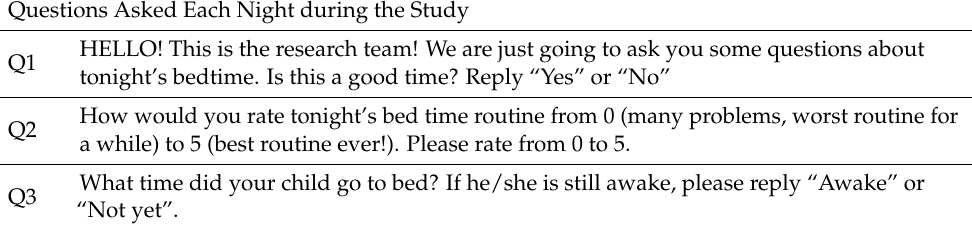
Table A1. Open and closed-ended questions sent to participants each night using the automated text survey system. Details: A list of questions parents received each night as part of the study. The questions were sent to parents’ mobile phones each night for the duration of the